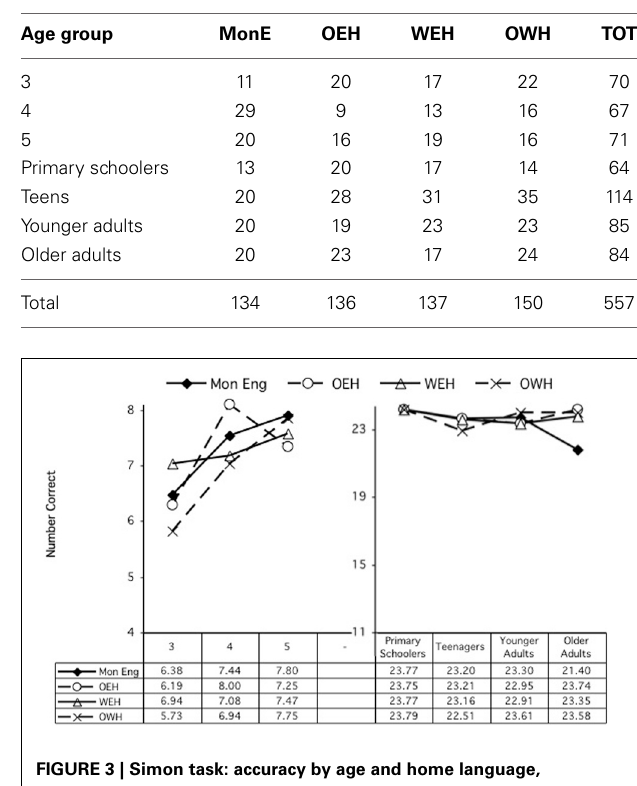
FIGURE 3 | Simon task: accuracy by age and home language, congruent